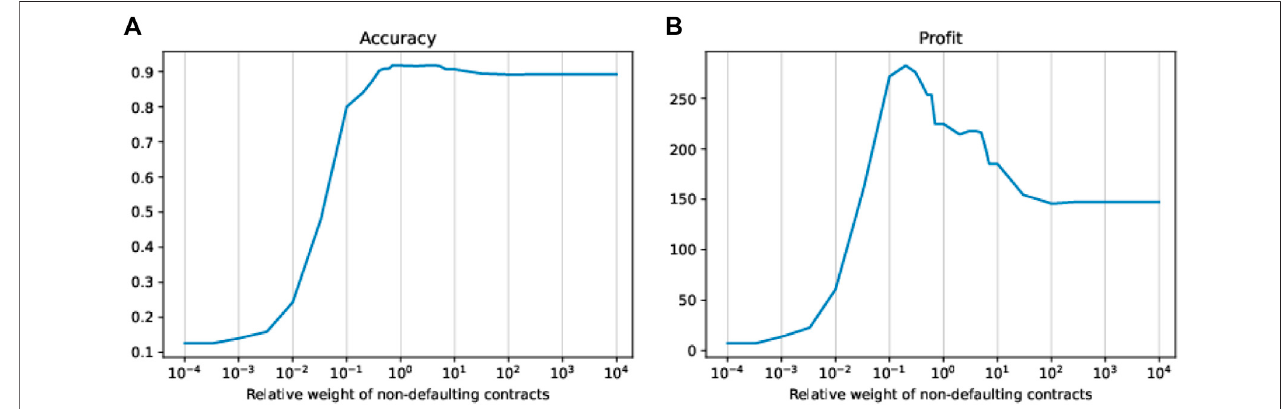
FIGURE 7 | In-sample accuracy (A) and in-sample pro fi t (B) of trees as a function of different relative weights of the non-defaulting contracts.